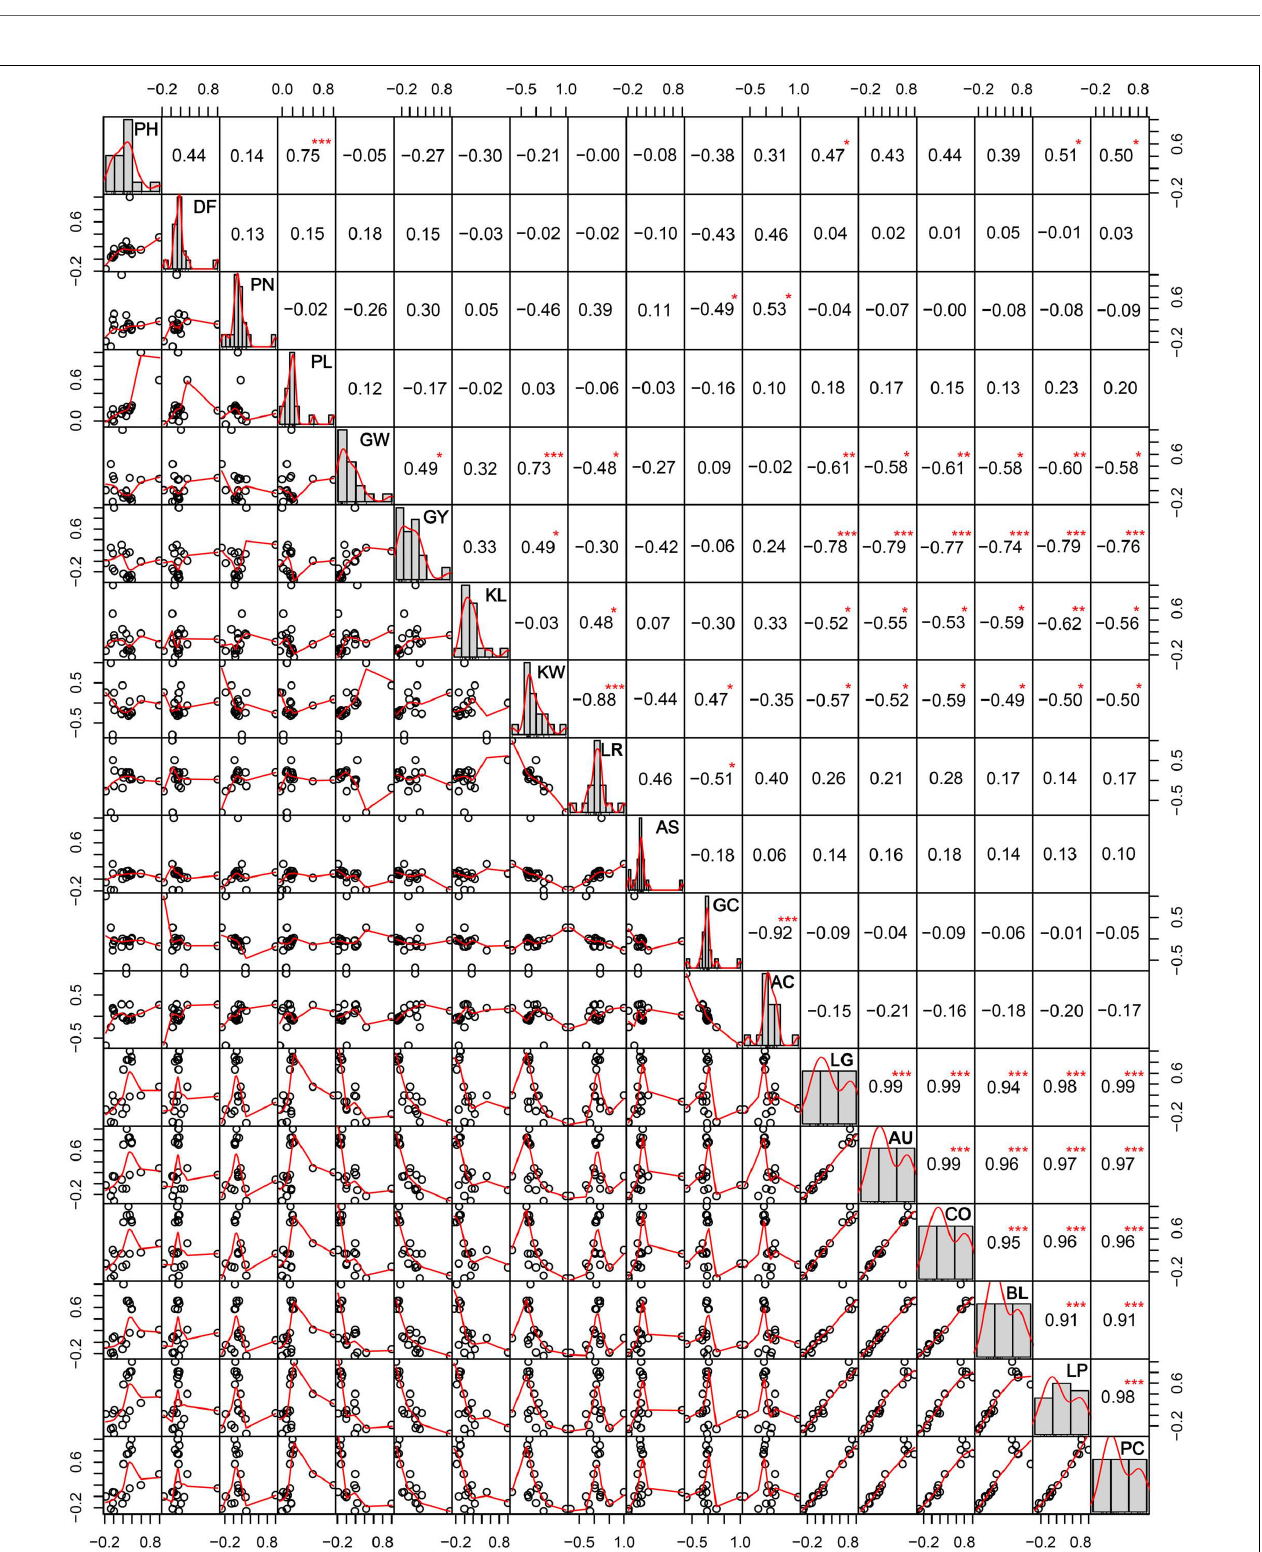
FIGURE 4 | Correlations among different agro-morphological traits in the aromatic rice germplasm of Manipur. PH, plant height in cm; DF, days to 50% flowering; PN, panicle number; PL, panicle length in cm; GW, weight of 1,000 grains in g; GY, grain yield per plant in g; KL, kernel length in mm; KW, kernel width in mm; LR, length to width ratio; AS, alkali spreading value; GC, gel consistency; AC, apparent amylose content in percentage; LG, ligule pigmentation; AU, auricle pigmentation; CO, collar pigmentation; BL, basal leaf color; LP, lemma and palea color; PC, pericarp color. *, **, *** Significant at probability levels of 0.05, 0.01 and 0.001, respectively.